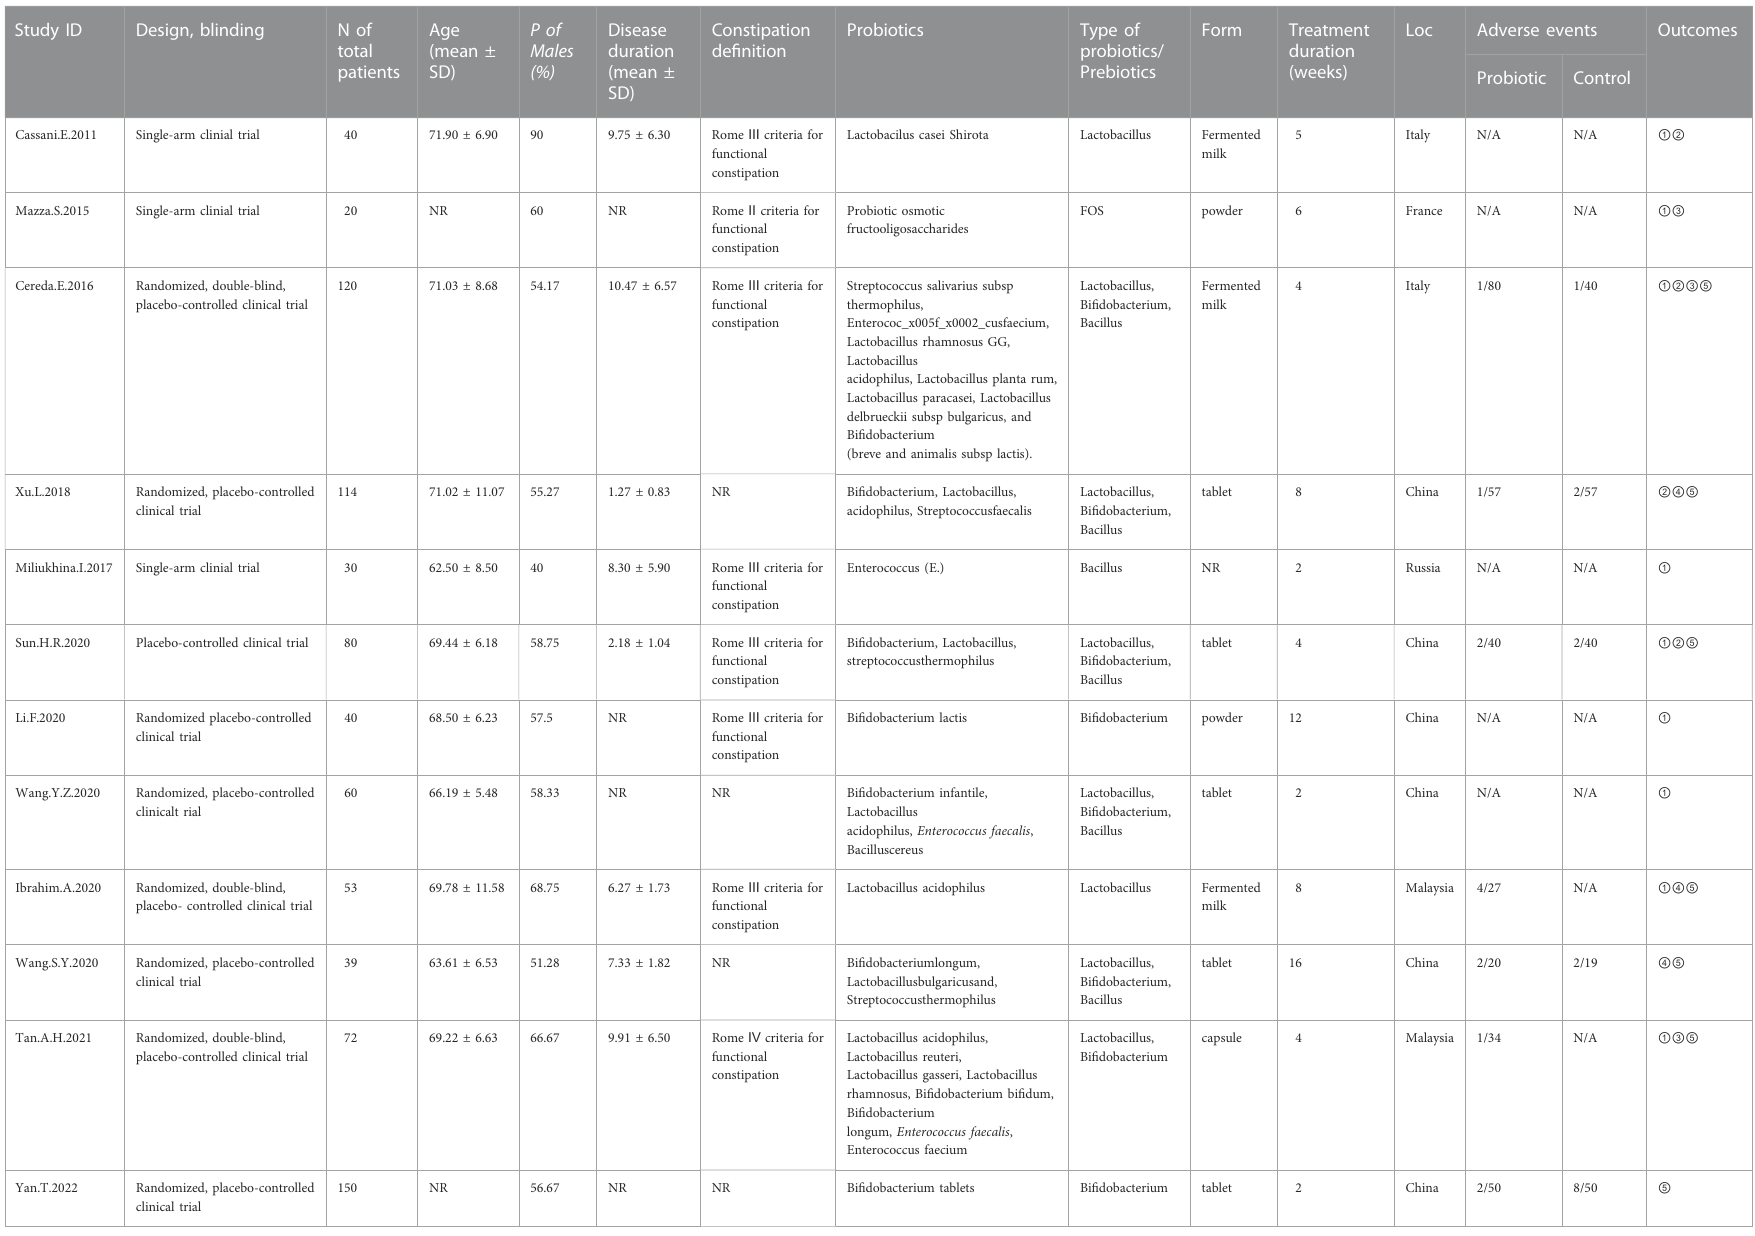
TABLE 1 Basic characteristics of the included studies in the